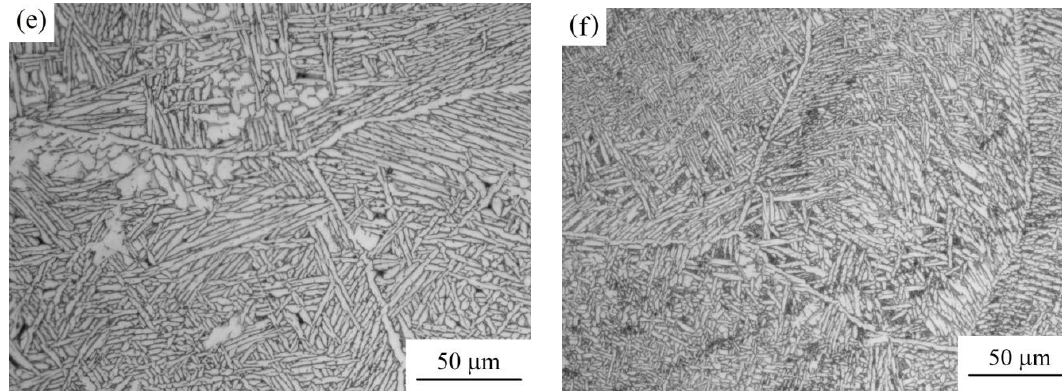
Figure 6. The microstructure of polished sections of the samples after etching according to optical